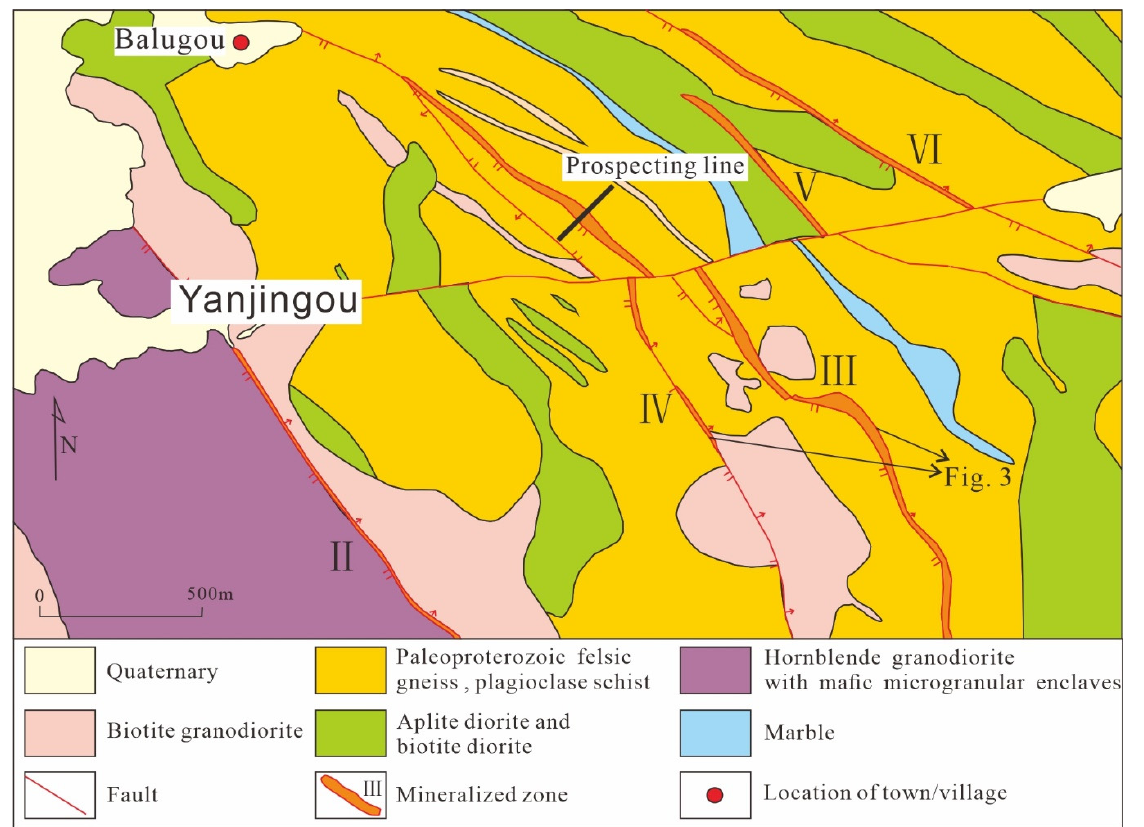
Figure 2. Geological map of the Yanjingou Au deposit (modified after [12]). The Yanjingou Au deposit is controlled by the northernmost ductile shear zone of the Wulonggou Au district and cut by many secondary faults. The faults are mostly NW–SE- trending and dip towards the northeast. A small number of nearly E–W- and N–S-trending faults are also developed. These faults controlled the formation and distribution of the Yanjingou Au